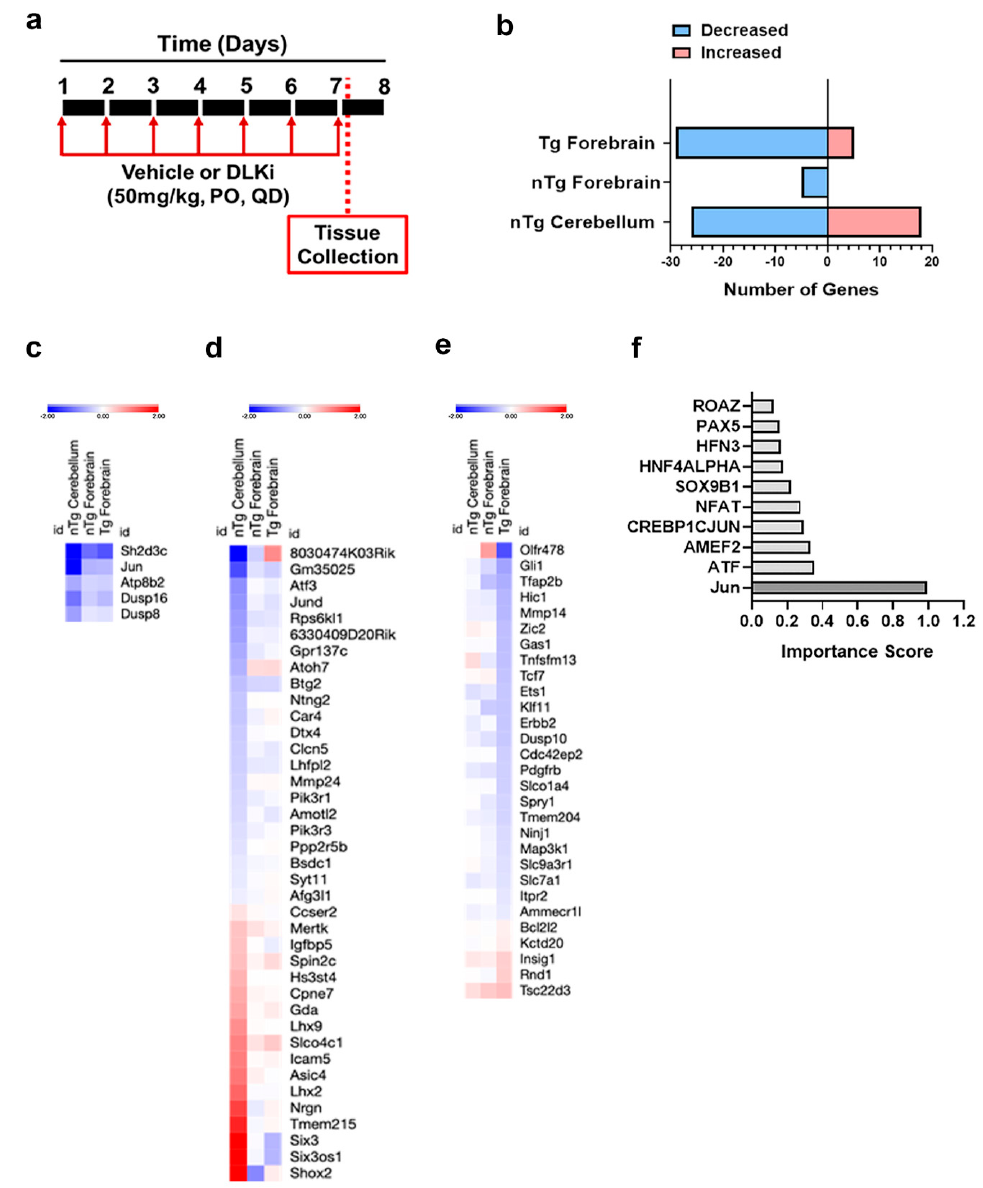
Figure 7. RNA-Seq analysis reveals a DLK-dependent gene signature in both the cerebellum and forebrain in nTg and Tg mice. ( a ) Schematic representation of study timeline. nTg ( n = 6) and Tg ( n = 6) mice were treated with 50 mg / kg of DLKi or vehicle QD for 7 days. The study was terminated approximately 2 h after the last dose. ( b ) Number of di ff erentially expressed genes (red = increased, blue = decreased; p adj < 0.05) due to DLK inhibition for each brain region × genotype is plotted. ( c ) Heatmap depicting the more robustly altered genes ( p adj < 0.05) due to DLK inhibition in nTg cerebellum, nTg forebrain, and Tg forebrain with relative gene expression changes (red = increased, blue = decreased) across genotype, treatment, and brain region for each sample ( n = 6 samples / group). ( d ) Heatmap depicting the more robustly altered genes ( p adj < 0.05) due to DLK inhibition specifically in nTg cerebellum with relative gene expression changes (red = increased, blue = decreased) across genotype, treatment, and brain region for each sample ( n = 6 samples / group). ( e ) Heatmap depicting the more robustly altered genes ( p adj < 0.05) due to DLK inhibition specifically in Tg forebrain with relative gene expression changes (blue = down; red = up) across genotype, treatment, and brain region for each sample ( n = 6 samples / group). ( f ) Promoter analysis using DiRE of the most significantly ( p adj < 0.05) altered DLK-dependent genes (listed in ( c – e